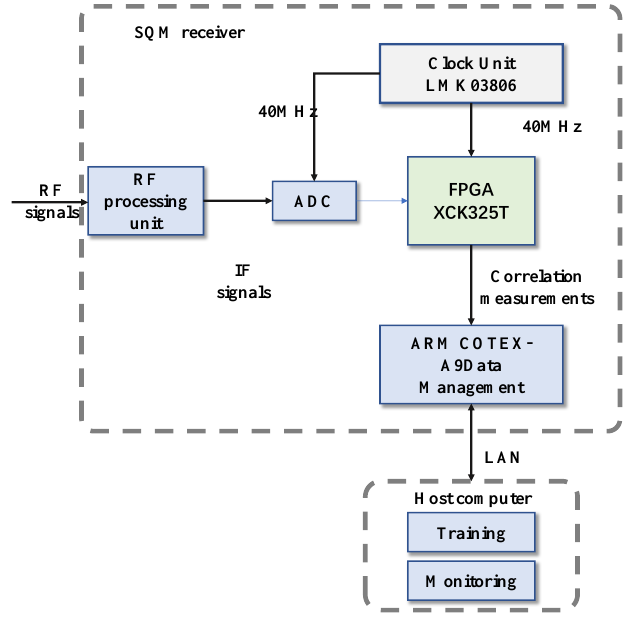
Figure 4. Selection process of training parameters.